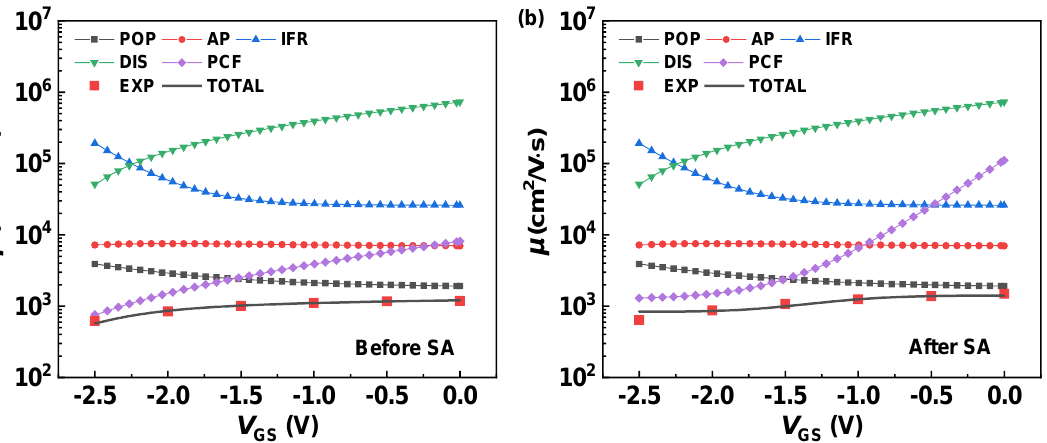
Figure 8. The calculated mobility as a function of gate-source voltage for PCF, POP, AP, IFR, and DIS scatterings as well as the total mobility (TOTAL) and the experimental mobility (EXP) at room temperature for the InAlN/GaN ( a ) Before TFSI surface treatment; ( b ) After TFSI surface treatment.